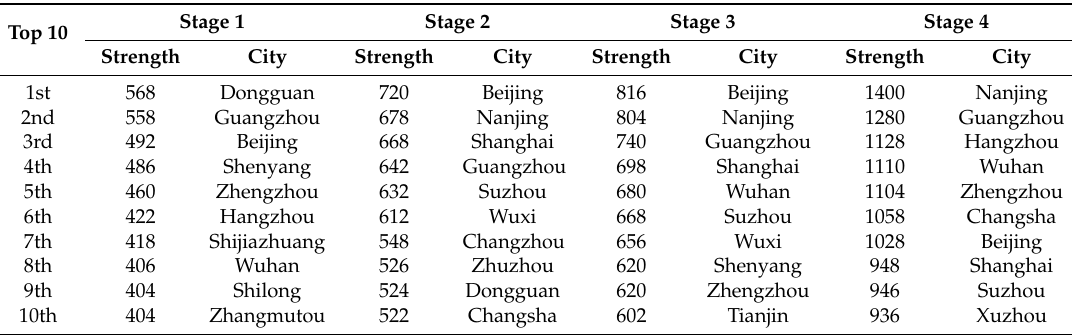
Table 8. Strength for the top 10 cities in four stages.